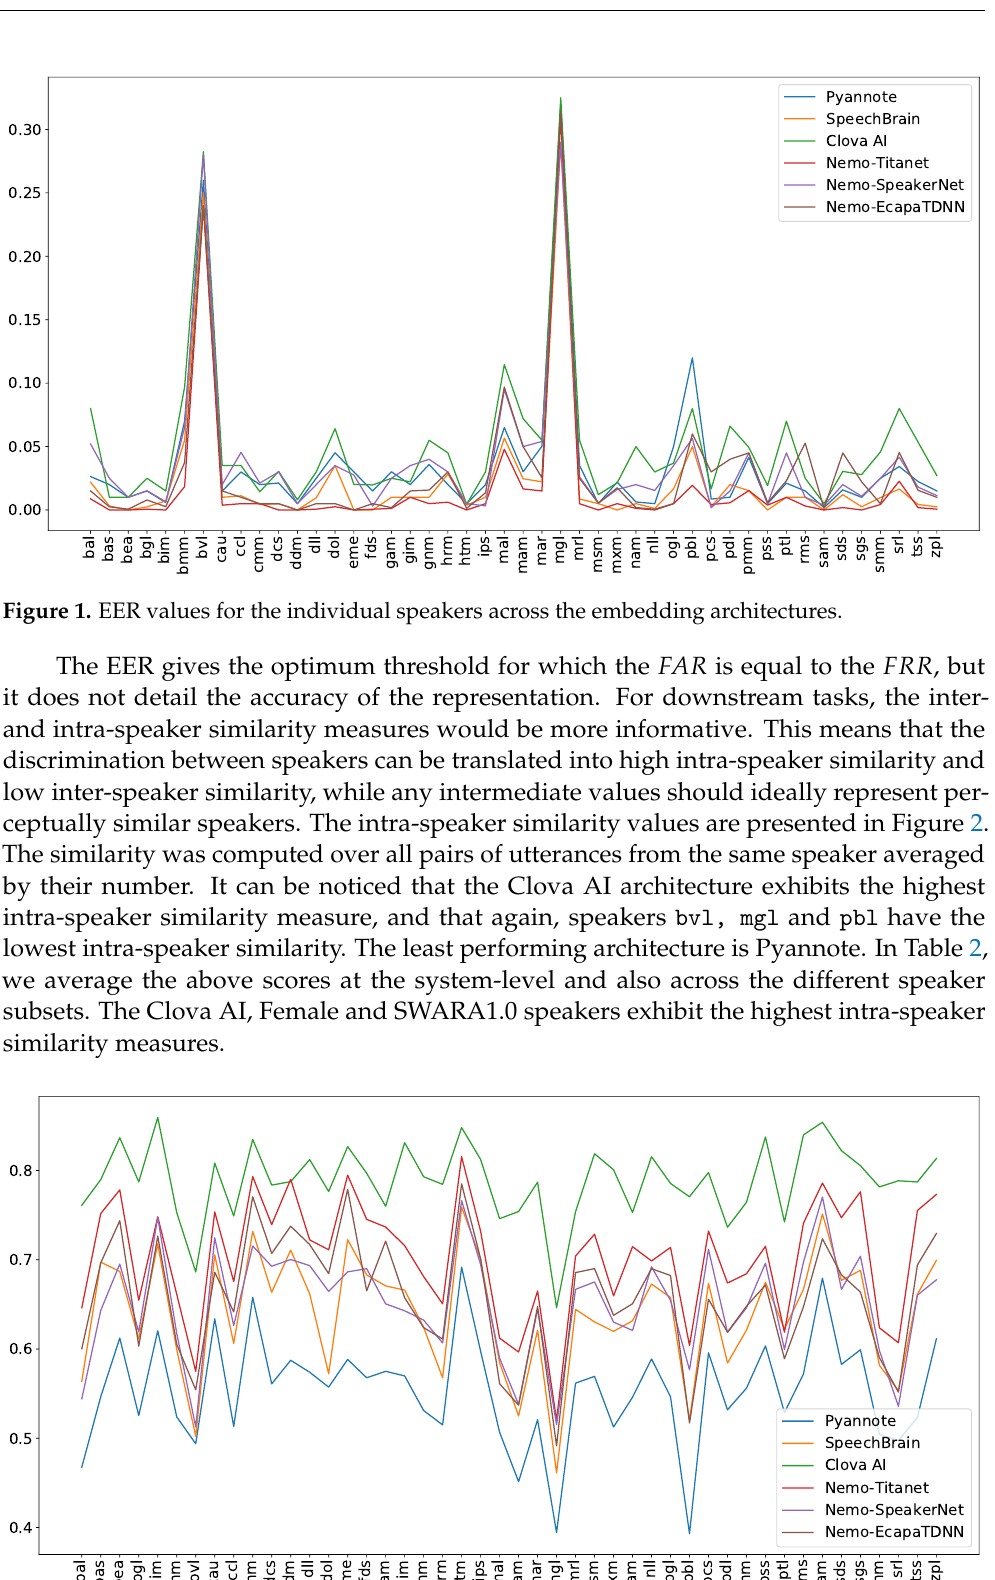
Figure 2. Intra-speaker cosine similarity for each speaker and embedding